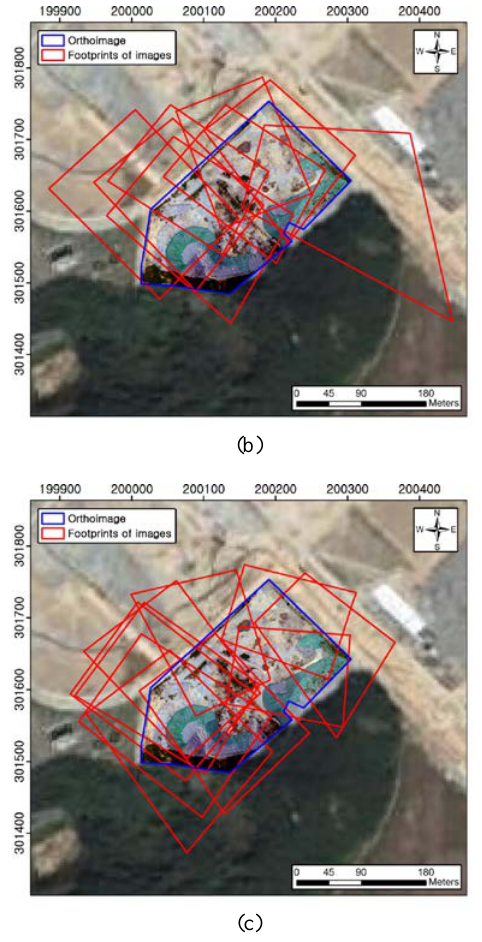
Figure 7. Overview of the image block: (a) Galaxy S, (b) S2 type A, and (c) S2 type